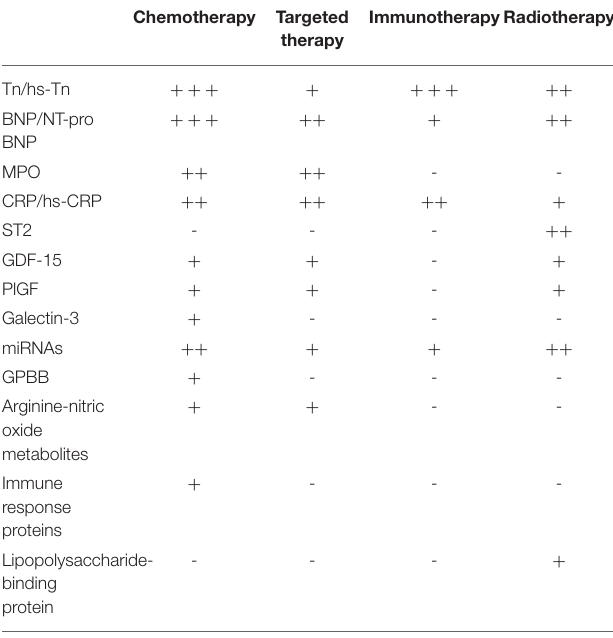
TABLE 2 | Predictive value of biomarkers for cancer treatments. Chemotherapy Targeted